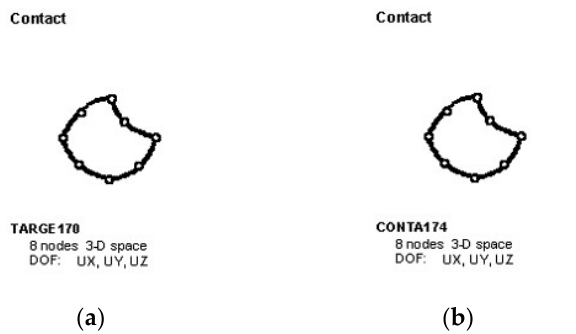
Figure 13. Schematic diagram of 3D contact pairs. ( a ) Diagram of TARGE170; ( b ) Diagram of CONTA174.